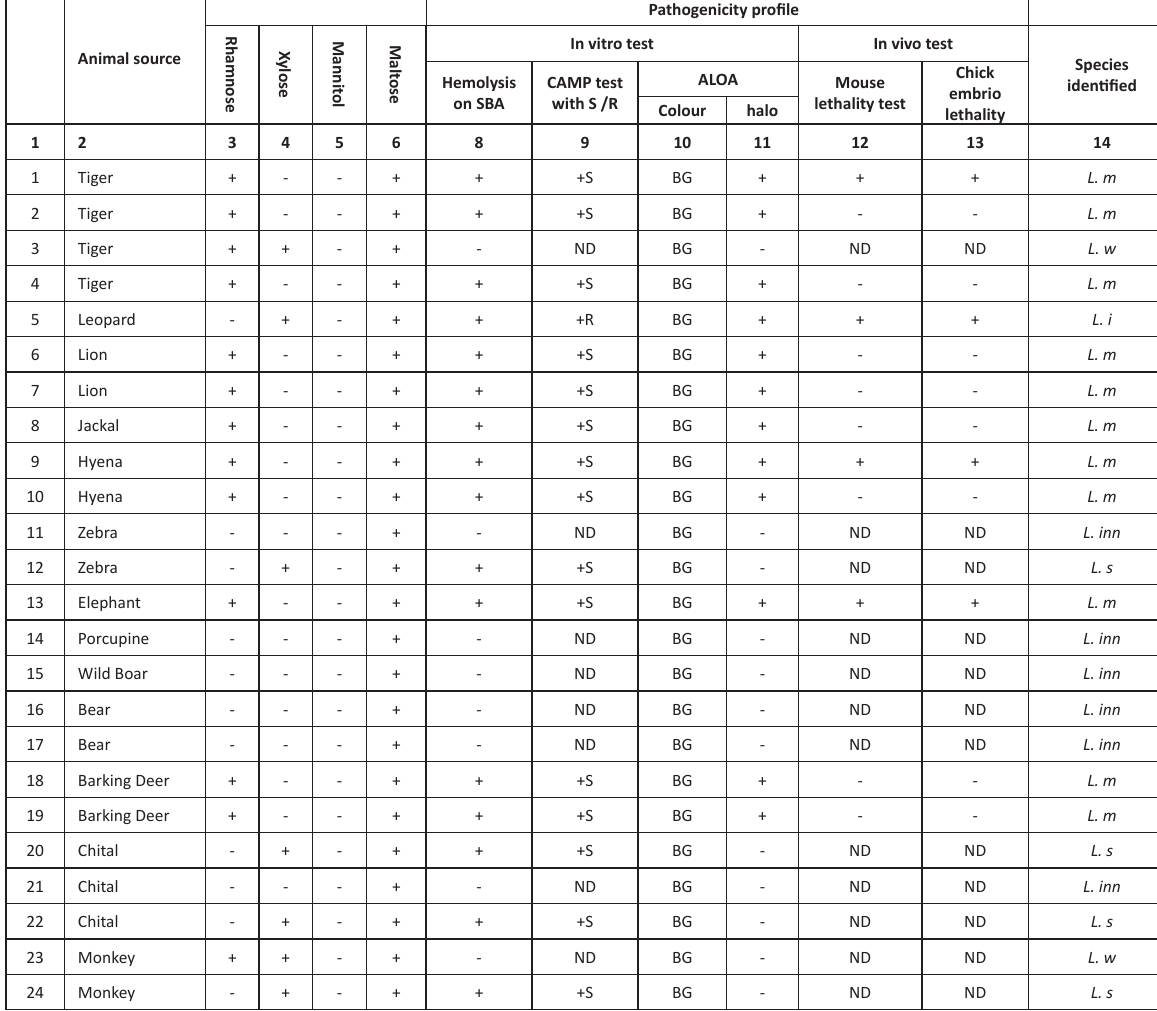
Table 2. differentiation and Pathogenicity test of Listeria isolates from faecal samples of wild animals in Nandankanan Zoo, Baranga, Odisha.